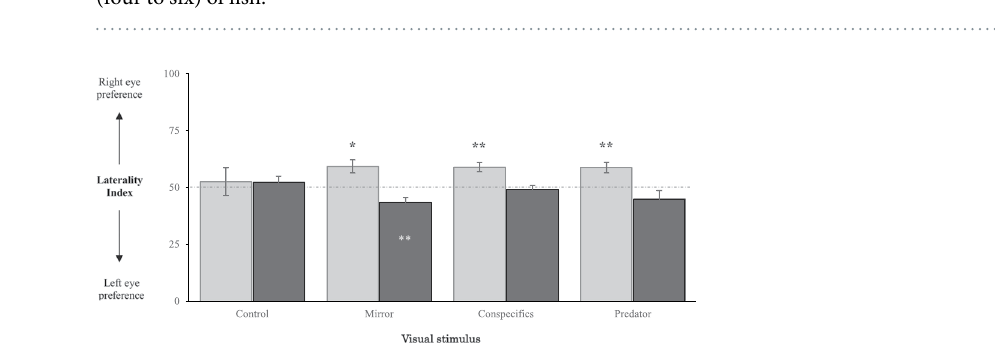
Figure 3. Ecological importance of brain lateralization in larval survival facing direct predation. Survival index (SI) was calculated as follows: survival rate of the group minus the overall survival rate in the in situ cage. Figure represents SI mean ( ± SE) values. The asterisk indicates a significant difference in survival index among the three groups (Kruskal-Wallis test, x 2 = 7.064, df = 2, p-value = 0.029) with ‘left-eye dominant’ experiencing higher survival than both ‘right-eye dominant’ (Nemenyi post-hoc test with Tukey-Dist approximation, p-value = 0.01) and ‘no eye dominant’ larvae (Nemenyi post-hoc test with Tukey-Dist approximation, p-value = 0.03). Six replicates were conducted. In each replicate, each group was made up with the same amount (four to six) of fish.